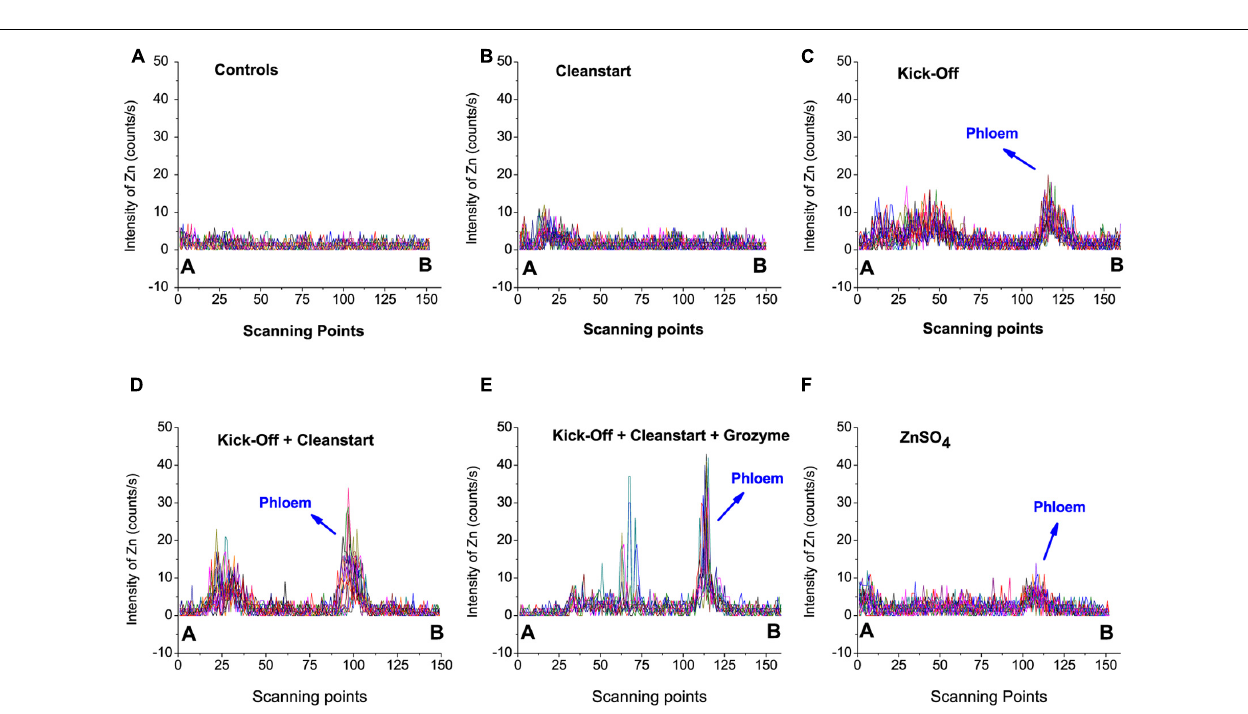
CleanStart + Kick-Off, (E) CleanStart + Kick-Off + GroZyme, and (F) ZnSO 4 . Compositions of the nutrients in different treatments were shown in Table 1 . Pixel brightness for μ -XRF map is displayed in RGB, with the brightest spots corresponding to the highest element fluorescence.